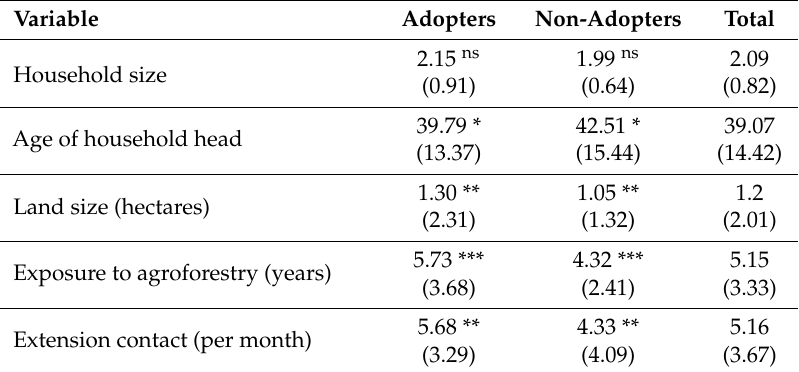
Table 4. Mean values for predictors between adopters and non-adopters ( n = 250).